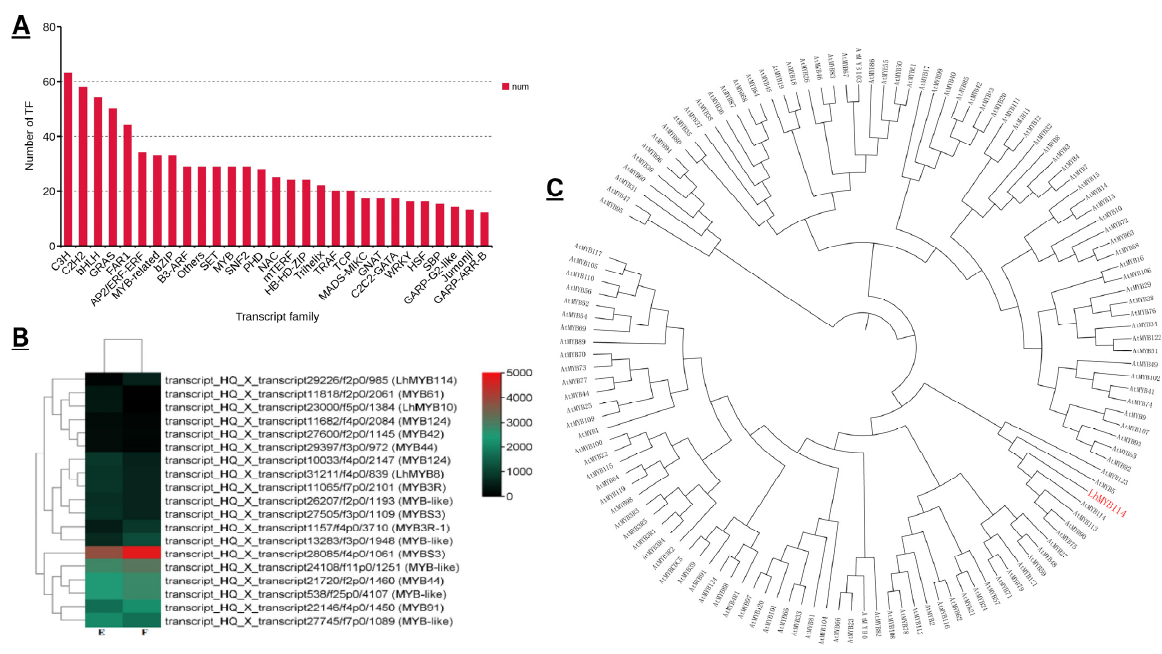
Figure 4. Genetic expressions of MYB genes and cluster analysis in transcriptome data. ( A ) The numbers and families of top 28 TFs enriched in flower bud. ( B ) The heatmap analysis of MYB DEGs through transcriptome data. The heatmap was generated based on the normalized log 2 (FoldChange) > 1 values for each DEG. The color scale at the right represents gene expression values (the red corresponds to genes with high expression and the green corresponds to genes with low expression). ( C ) The cluster analysis map of R2R3-MYB proteins. The cluster analysis tree was completed using MEGA 5.0 software with the Arabidopsis MYB genes as reference. The aim gene of LhMYB114 is highlighted in red color.